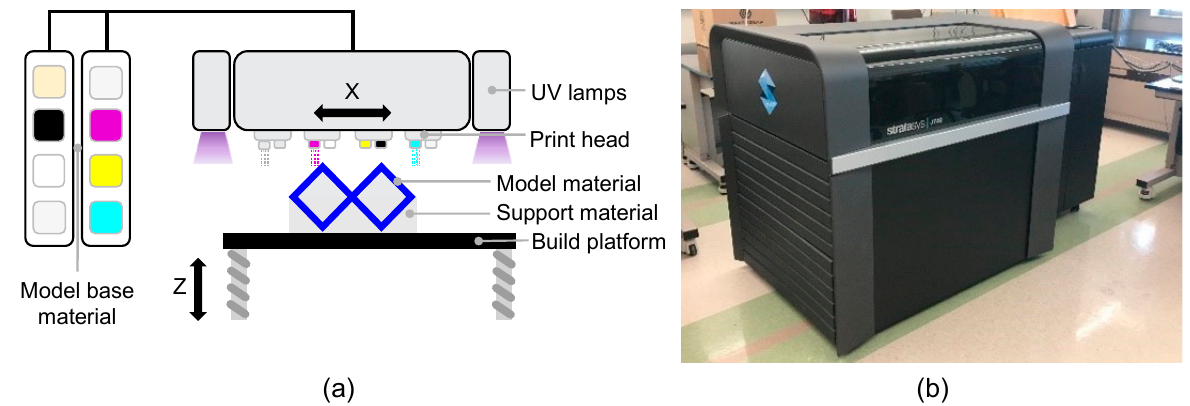
Figure 1. PolyJet 3D printing. ( a ) Illustration of the PolyJet printing process, and ( b ) picture of the Stratasys J750 PolyJet printer.